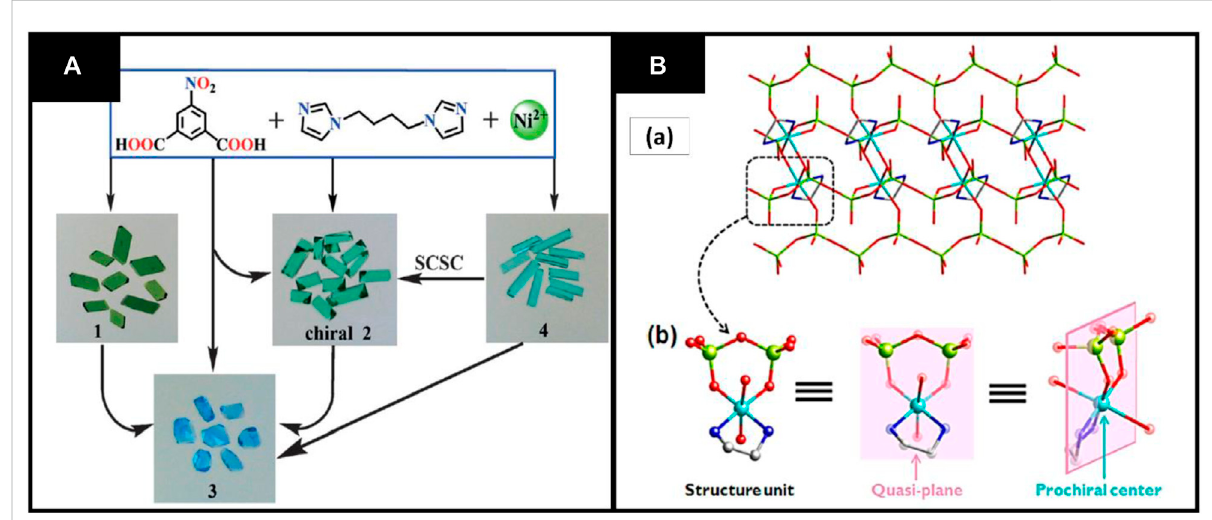
FIGURE 4 (A) Transformation of SCSC 1 – 4. Reproduced with permission from (Gu et al., 2015) (B) (A) Prochiral center and quasi-plane structural unit. Reproduced with permission from (Dhakshinamoorthy et al.,